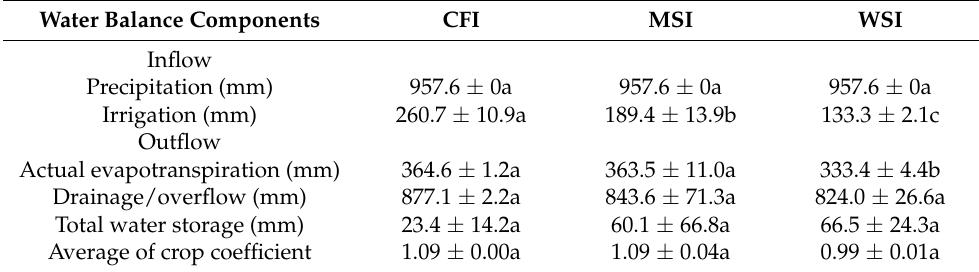
Table 3. Water budget in each regime.